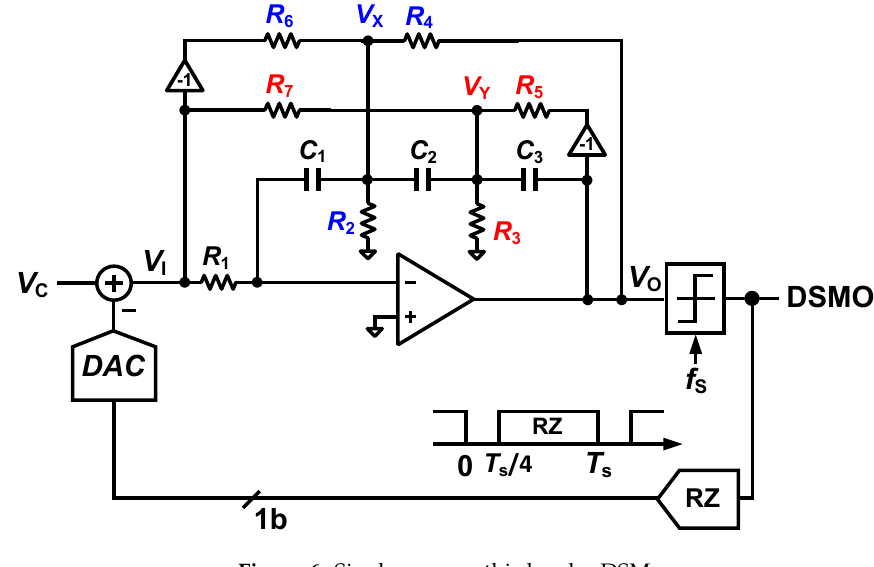
Figure 6. Single op-amp third-order DSM.